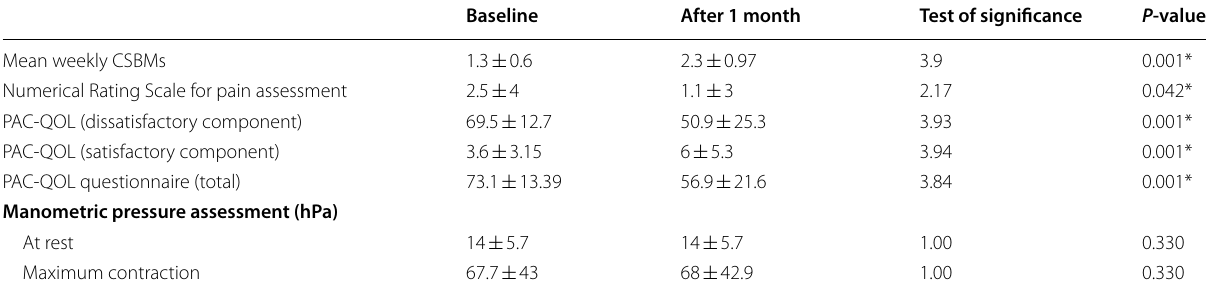
hPa hectopascal (it is the unit of pressure, and it is equal to 100 Pa), CSBMs Complete spontaneous bowel movements, PAC-QOL Patient Assessment of Constipation Quality of Life questionnaire Significant P 0.05 ≤ * P -value of the paired t -test